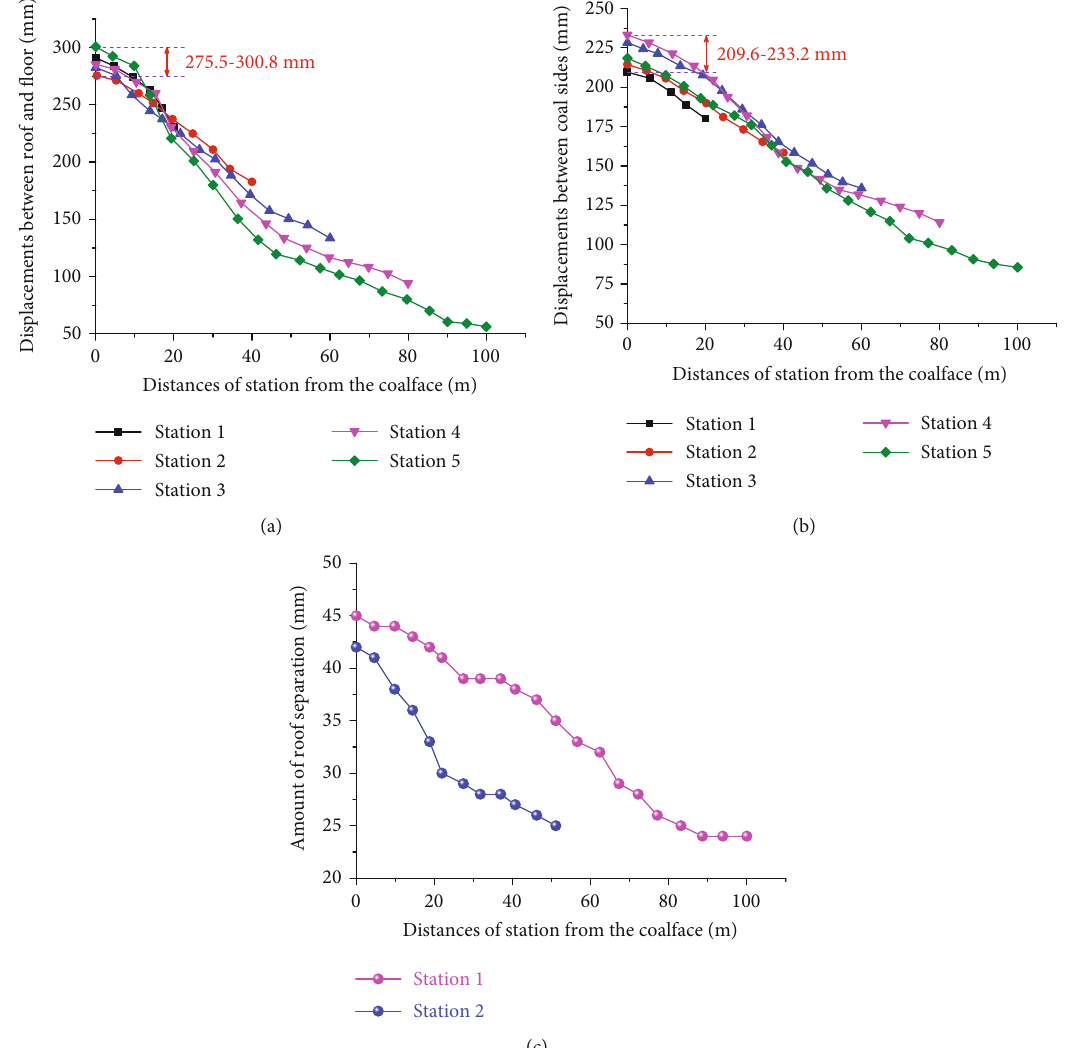
Figure 13: Surface deformation and amount of roof separation in the roadway: (a) displacement between the roof and fl oor; (b) displacement between the coal sides; (c) amount of roof